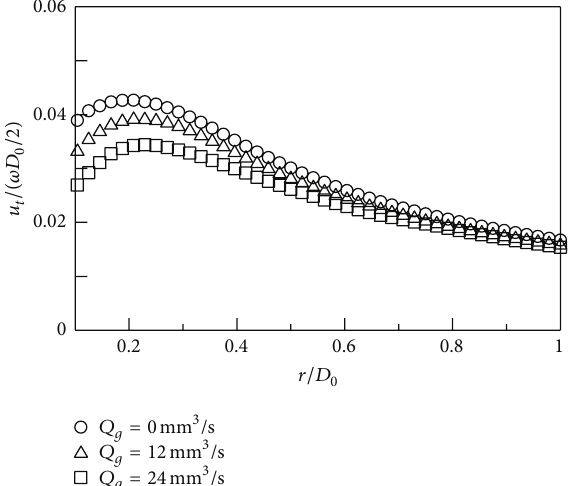
Figure 12: Change in circumferential velocity of water at 𝑧/𝐷 0 = 4.17 when Ω = 7.9 × 10 4 .